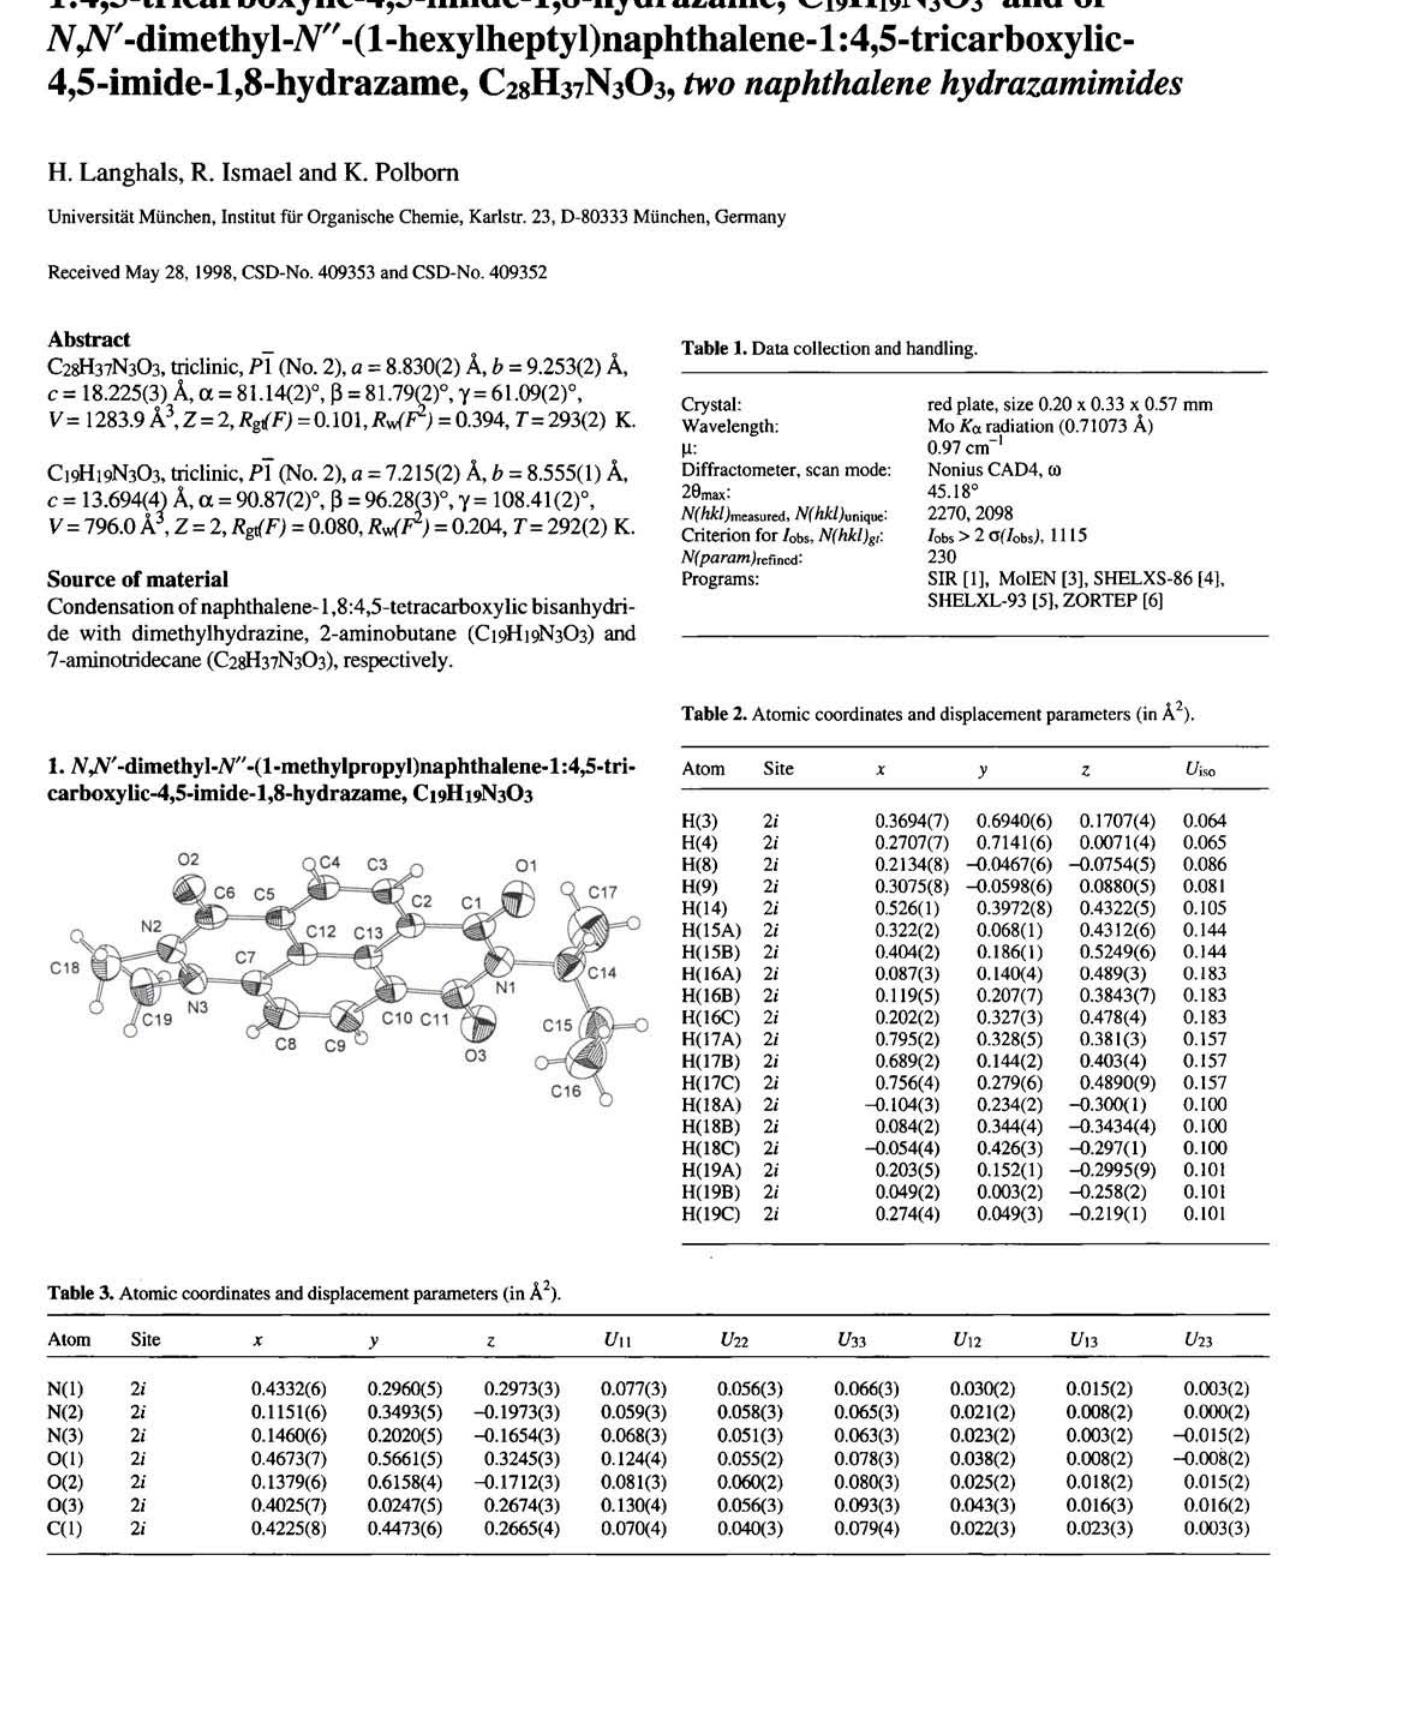
Table 1. Data collection and handling. Crystal: